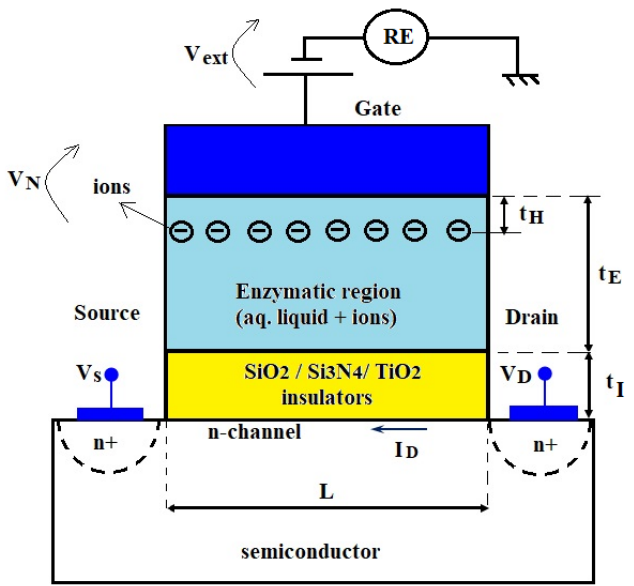
Figure 2. The structure of the modeled ENFET, where t I is the sum of thicknesses for all inorganic insulators and t E is the thickness of the enzymatic region; the n-type channel and the negative ions are considered as a possible example.